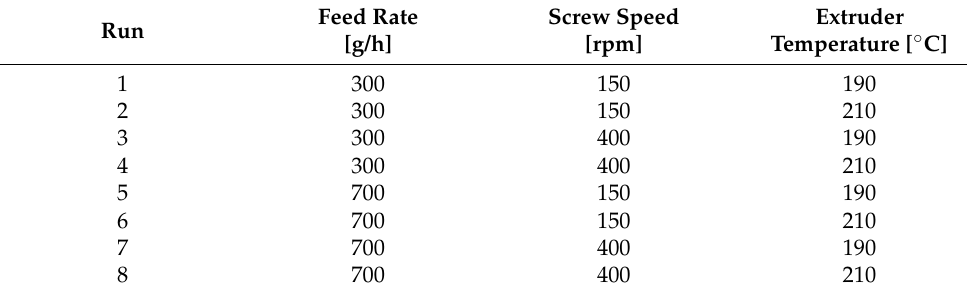
Table 2. Orthogonal array of the experimental runs.